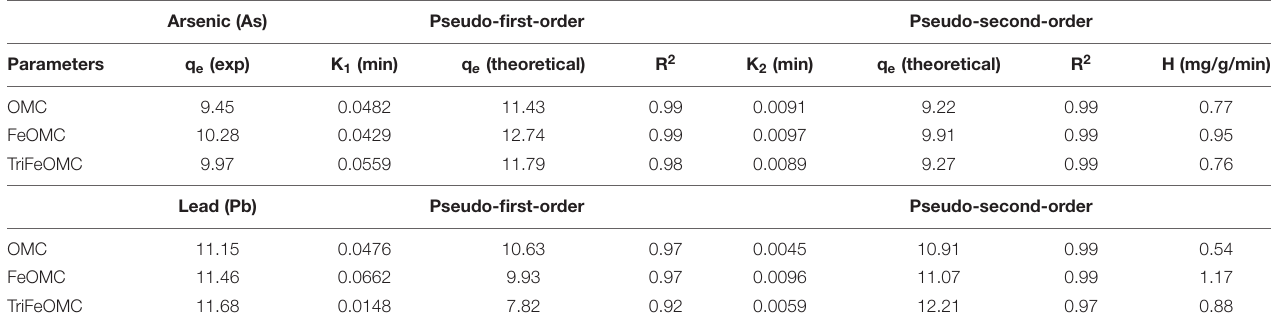
TABLE 1 | The parameters of adsorption kinetics of arsenic and lead on OMC, FeOMC, and TriFeOMC at pH 7 ( R 2 is the correlation coefficient of the model fits) using non-linear models. Arsenic (As) Pseudo-first-order Pseudo-second-order